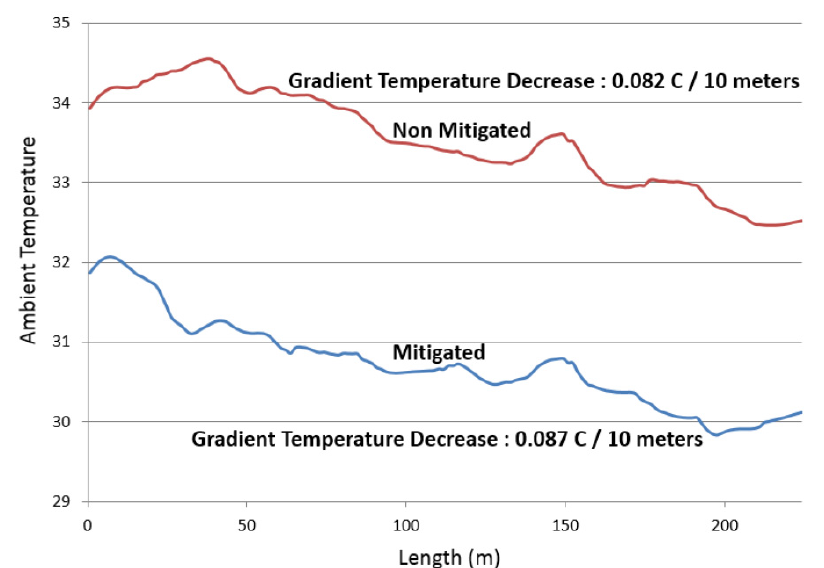
Figure 7. The GTD for the CT1 precinct for both mitigated and unmitigated scenarios is shown in the ENVI-met configuration.